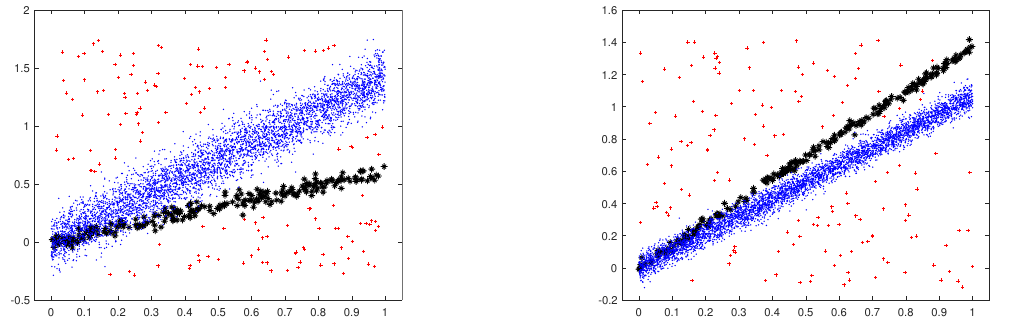
Figure 6. Two artificial datasets generated with MixSim for the assessment: 4750 observations from the dominant linear component (blue dots) + 250 observations from a contaminating linear component (black stars) + 150 observations from uniform contamination (red